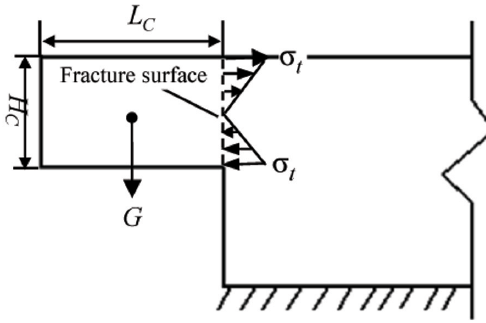
Figure 10. Critical fracture state of a